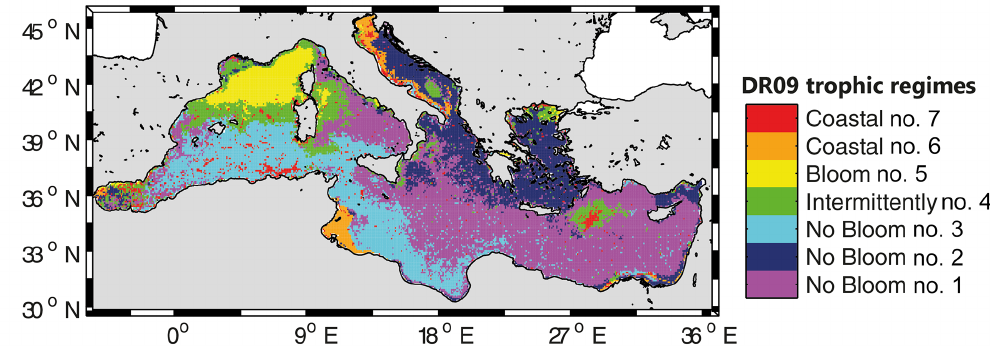
Figure 8. Spatial distribution of the climatological trophic regimes obtained from the DR09 methodology (i.e., a K-means) applied on a weekly climatology calculated from the 16-year